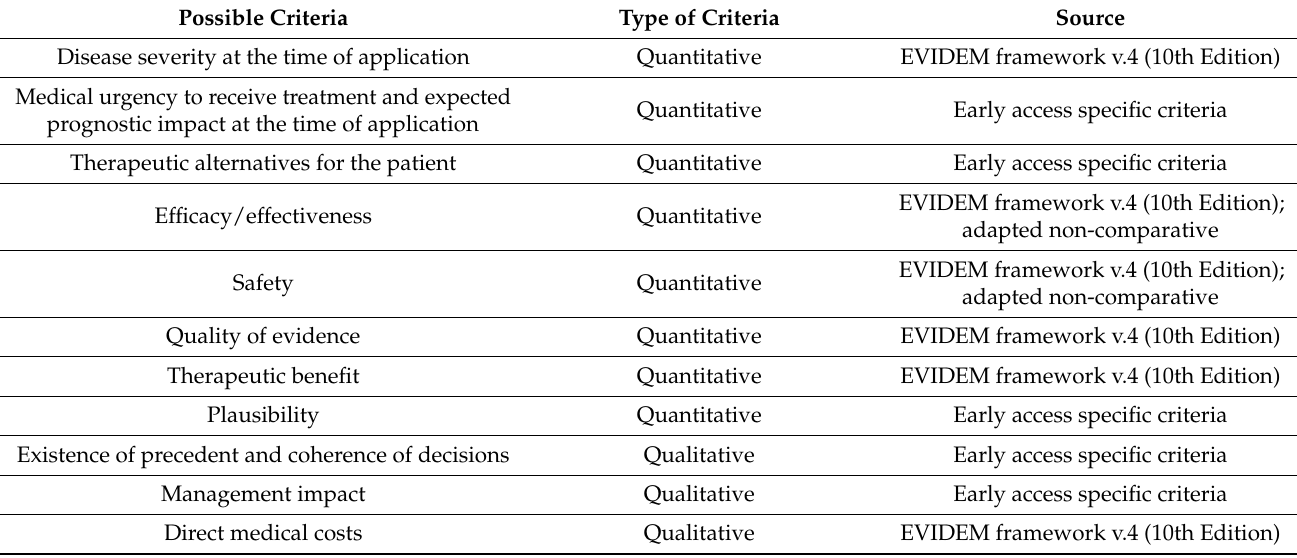
Table 1. Criteria considered in the pilot early access